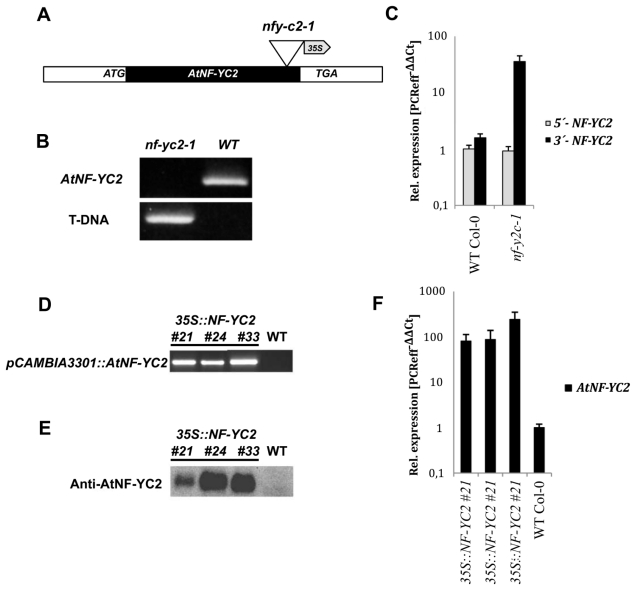
Analysis of the Arabidopsis nf-yc2 mutant and NF-YC2 overexpressor lines: (A) Schematic T-DNA-insertion site in AtNF-YC2; (B) Experimental confirmation of homozygosity of the T-DNA-inserted allele in nf-yc2 in comparison to wild type. A PCR product of the endogenous NF-YC2 gene could not be generated from DNA of nf-yc2; (C) The content of NF-YC2 RNA in nf-yc2 and control seedlings. The content of the NF-YC2 RNA was determined with primer pairs upstream and downstream of the T-DNA insertion site in NF-YC2. A T-DNA-mediated stimulation leads to accumulation of 3′ transcripts in nf-yc2 compared to control; (D) The 35SCaMV::AtNF-YC2 transgene was detected in the genomic DNA of the three representative transgenic lines #21, #24 and #33 in comparison to the wild-type genome; (E) Immunodetection of NF-YC2: Among the primary transformants the lines #21, #24 and #33 were selected to examine the NF-YC2 expression. By means of anti-NF-YC2 antibodies the overproduction of NF-YC2 could be examined in plant extracts. The wild-type extract contains non-detectable amounts of NF-YC2; (F) Relative expression level of AtNF-YC2 in wild-type and transgenic lines. Progenies of the T2 generation of the three transgenic lines were subjected to semi-quantitative RT PCR.